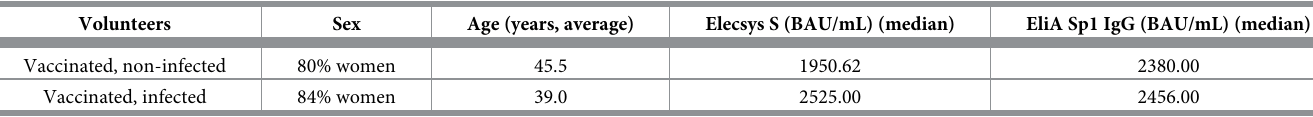
Table 1. Vaccinated volunteers’ demographic and serological data